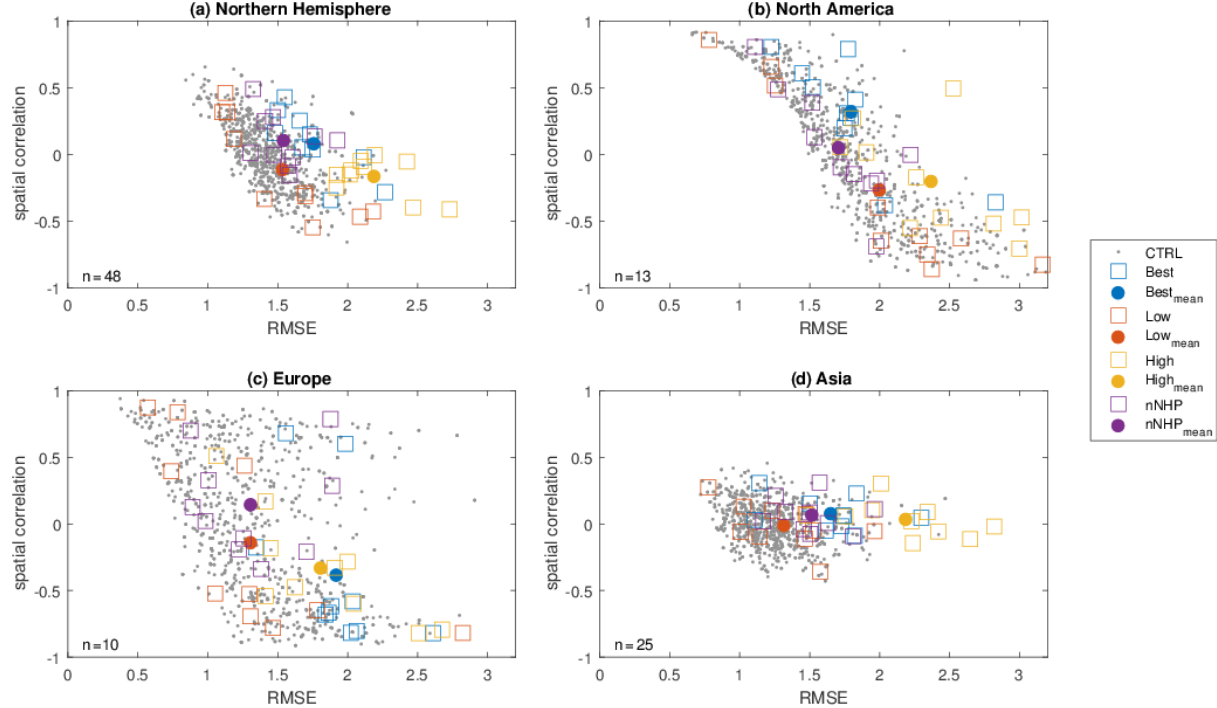
Figure 11. Scatterplots of root mean square error (RMSE) versus spatial correlation between simulated NH summer temperature and the N-TREND (S) reconstruction (Anchukaitis et al., 2017) for summer 1810 and different regions: (a) whole Northern Hemisphere, (b) North America (180–60 ◦ W), (c) Europe (60 ◦ W–60 ◦ E), (d) Asia (60–180 ◦ E). Individual model realizations are indicated by squares, and the ensemble mean is indicated by a full dot; small grey dots are for 1000 random samples from the control period (1800 to 1808). Analysis is restricted to grid points for which proxy data are available (number of data used for each region reported in the respective